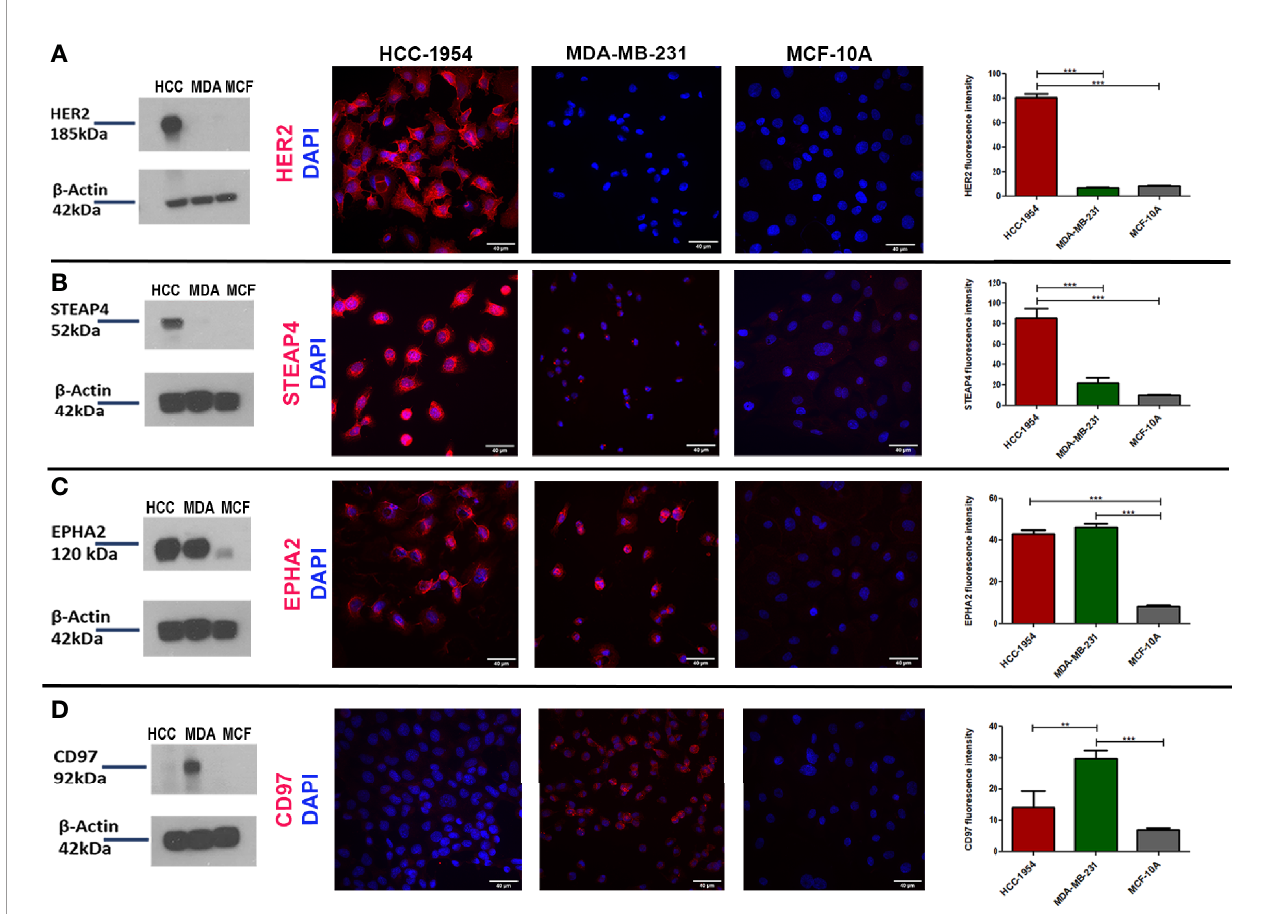
FIGURE 3 | Veri fi cation of the expression pattern of the selected protein targets identi fi ed by GeLC-MS/MS with Western blot and Immuno fl uorescence (IF) analysis. (A, B) Consistent with the proteomic results, Western blot detection of HER2 and STEAP4 in BC cell lines was only found in HCC-1954 (HER2+) cells. IF qualitative and relative quantitative results of HER2 and STEAP4 con fi rmed their overexpression in HCC-1954 cells as compared to the control MCF-10A and the MDA-MB-231 (TNBC) cells (***p < 0.001). (C) EPHA2 was highly expressed in MDA-MB-231 and HCC-1954 but faintly detectable in the control MCF-10A cells by Western Blot and IF qualitative and quantitative analysis, as we expected from the proteomic results (***p < 0.001). (D) CD97 expression was only detected in MDA-MB-231 (TNBC) through Western blot and IF results (**p < 0.01, ***p < 0.001). Scale bars in the IF images represent 40